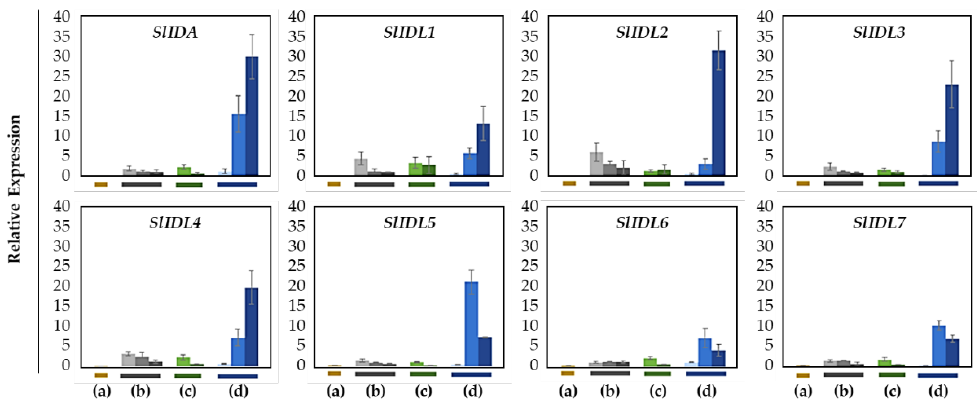
Figure 4. Relative gene expression of SlIDA for the AZ/NAZ in the four tomato variants. (a) jointless (j), (b) functionally impaired jointless (fij), (c) functionally impaired jointless like (fij like), and (d) normal joint (NJ). Except for the j (collected from only the midpoint), samples of AZ and NAZ (proximal side of pedicel) from several flower developmental stages available on the peduncle of the variant that covers a relatively broad range of flower abscission development were collected (Figure S1). One developmental stage of j, three developmental stages of fij, two developmental stages of fij like, and three developmental stages of NJ were collected. The samples from two neighboring peduncles on the primary inflorescence were utilized and combined for the respective developmental stages of AZ and NAZ samples from each peduncle to enrich the samples for RNA extraction. Each bar graph (AZ/NAZ), except for the j, of the natural abscission variant, represents the result from those several flower abscission developmental stages. The means ± SD of three independent replicates were used to present data sets.